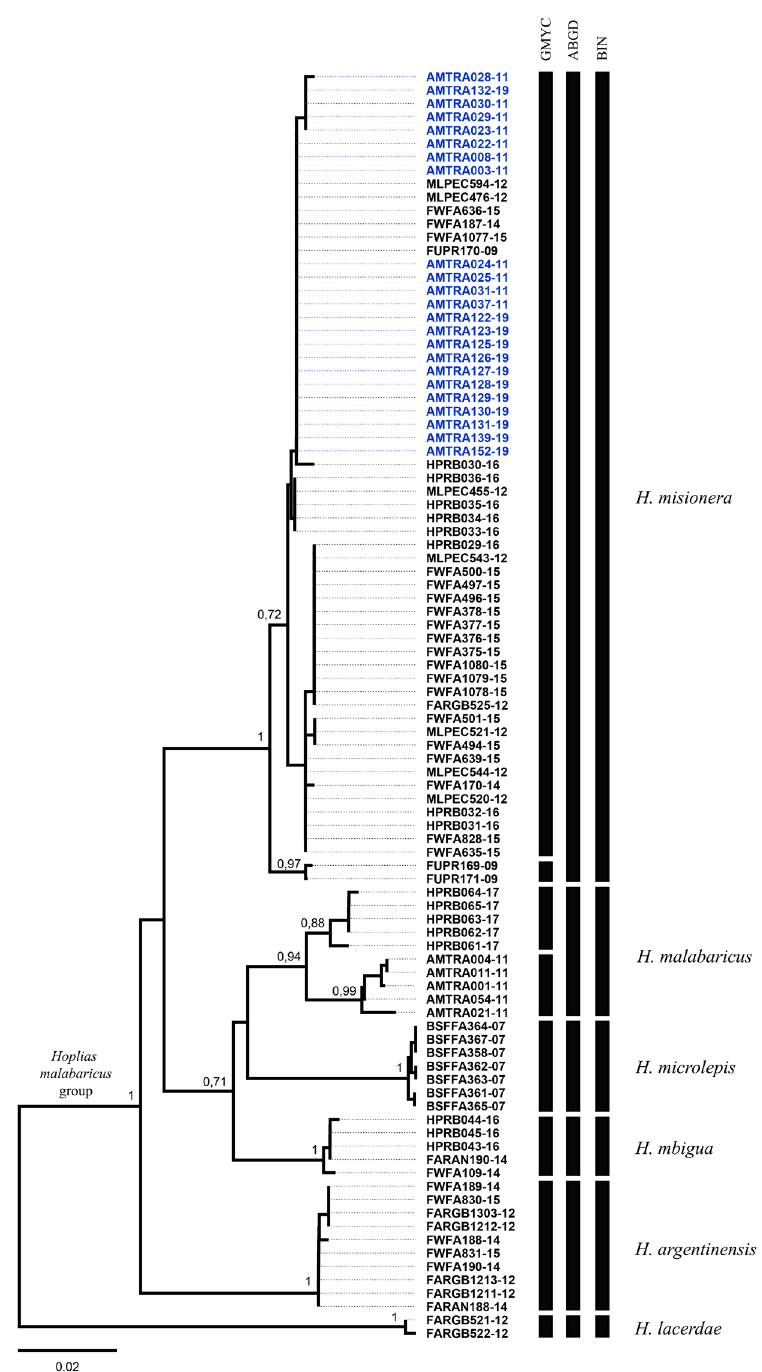
FIGURE 4 | Neighbor joining (NJ) tree of Hoplias inferred from partial COI (Cytochrome c Oxidase Subunit I gene) sequences using the Kimura 2-parameter model. The lateral bar indicates the partitions of species delimitation performed by the GMYC, ABGD and BIN analysis. The clade Hoplias misionera nested individuals from the La Plata and Amazon basins (blue